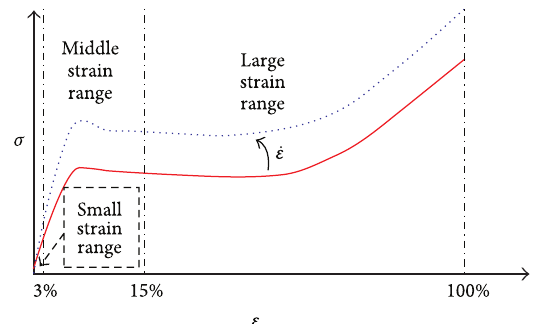
Figure 2: Stress/strain curve of amorphous glassy polymers in tensile test: the small strain level corresponds to linear viscoelas- ticity, the large strain level can be well described by an elastic- viscoplastic model, and the middle strain level should account for both viscoelasticity and